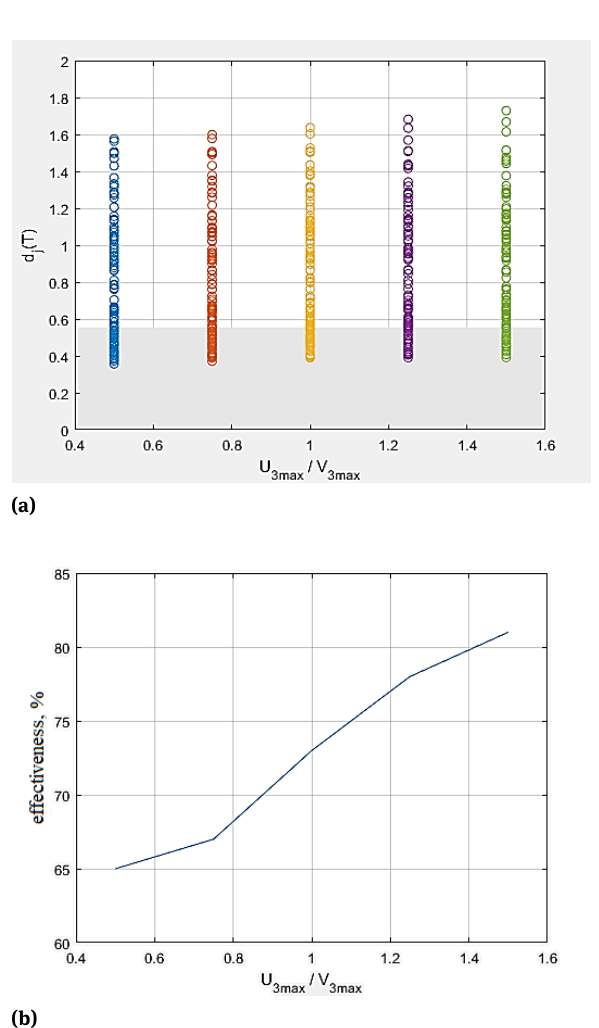
Figure 3: Influence of the “rate of climb” of the attacked UAV in comparison with the UAV-interceptor on the positional advantage achieved by it.